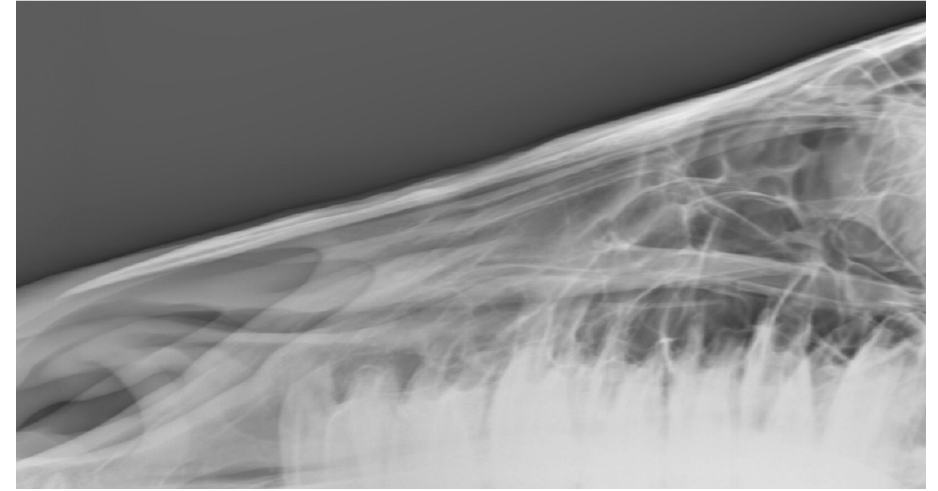
Figure 10. Radiograph showing the nasal bones of a horse in which radiologists ( n = 2) agreed there was both bone thinning and bone deposition.